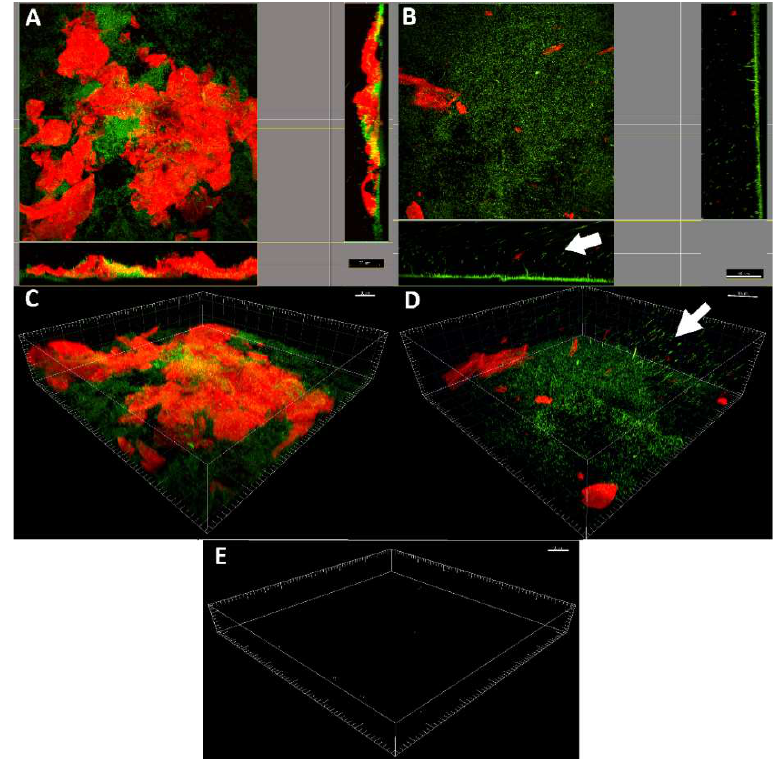
Figure 3. Confocal laser scanning microscopy analysis. Representative projection analysis ( A , B ) and three-dimensionally (3D) reconstructed CLSM images ( C , D ) of E. coli biofilm grown on non-functionalized LDPE surface ( A , C ) and LDPE-α-CT ( B , D ) functionalized surface (63×, 0.9 NA water immersion objective). The arrows indicate cells detaching from the biofilm. Live cells were stained green with SYBR Green I (λ ex at 488 nm, λ em at 520 nm), whereas the polysaccharide matrix was stained red with Texas Red-labeled concanavalin A (ConA) (λ ex at 543 nm, λ em at 615 nm). ( E ) Representative 3D reconstructed CLSM images of LDPE and LDPE-α-CT without biofilm and stained with SYBR Green I or Texas Red-labeled ConA showing no detectable fluorescence. Scale bar = 20, 30, or 40 µm.